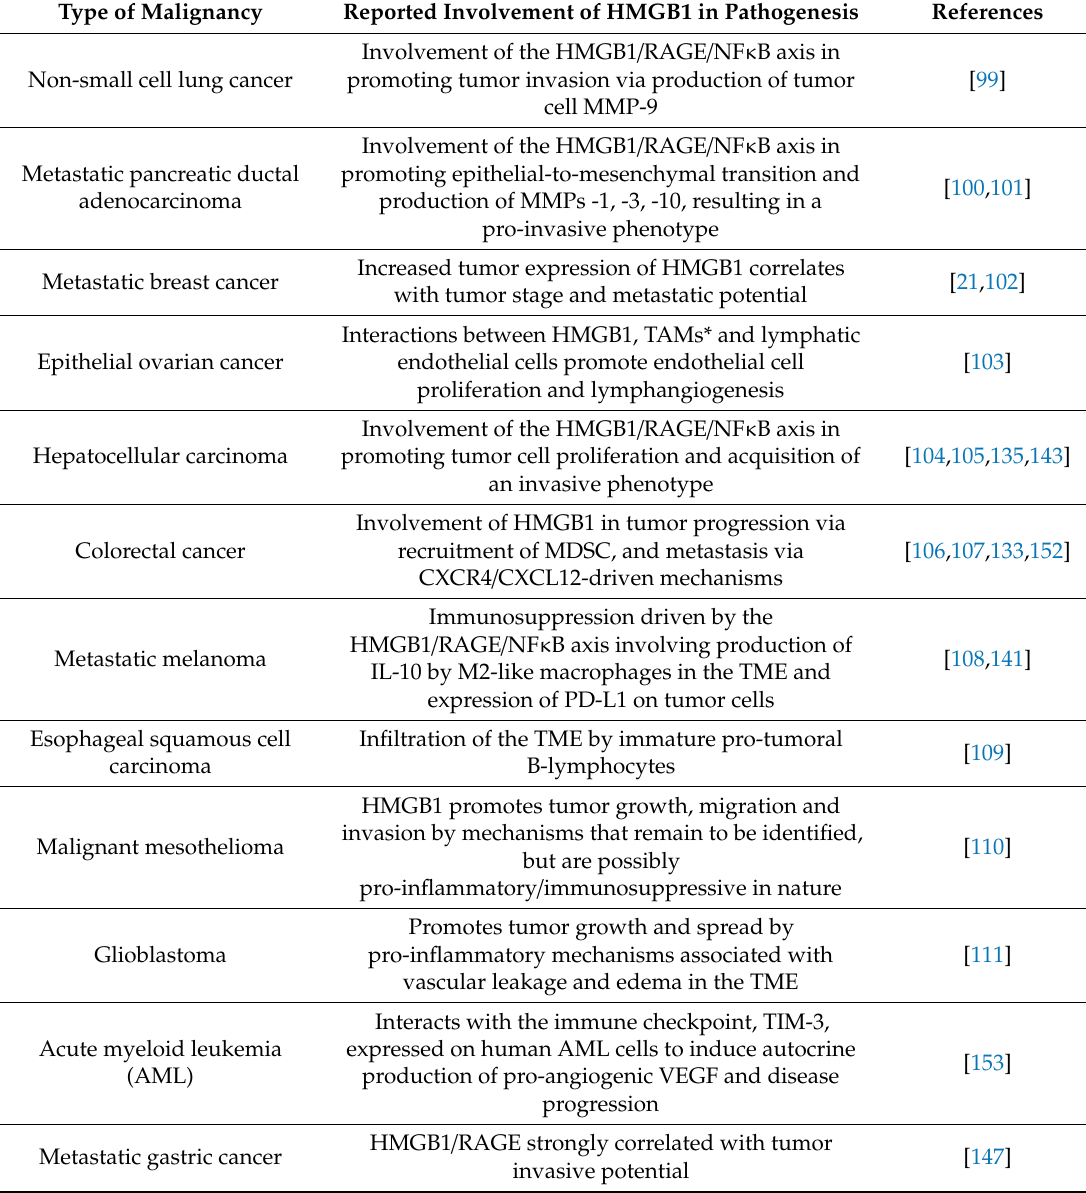
Table 2. Some human cancers in which HMGB1 has been implicated in disease